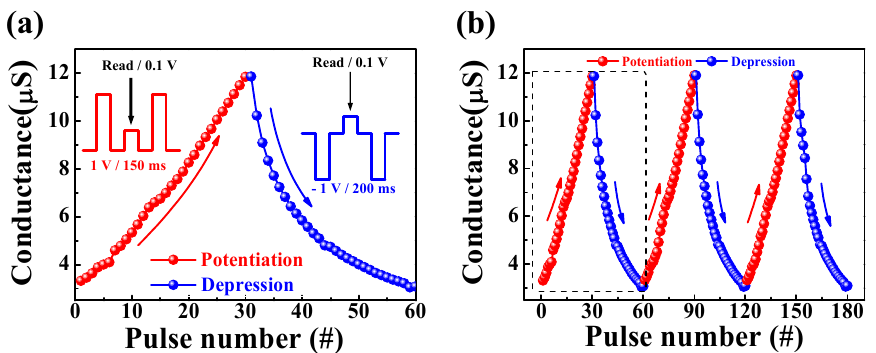
Figure 8. ( a ) Potentiation and depression behaviors by applying pre−synapse pules with conditions of 1 V for 150 ms and −1 V for 200 ms. ( b ) Three−cycle endurance of potentiation and depression behaviors.